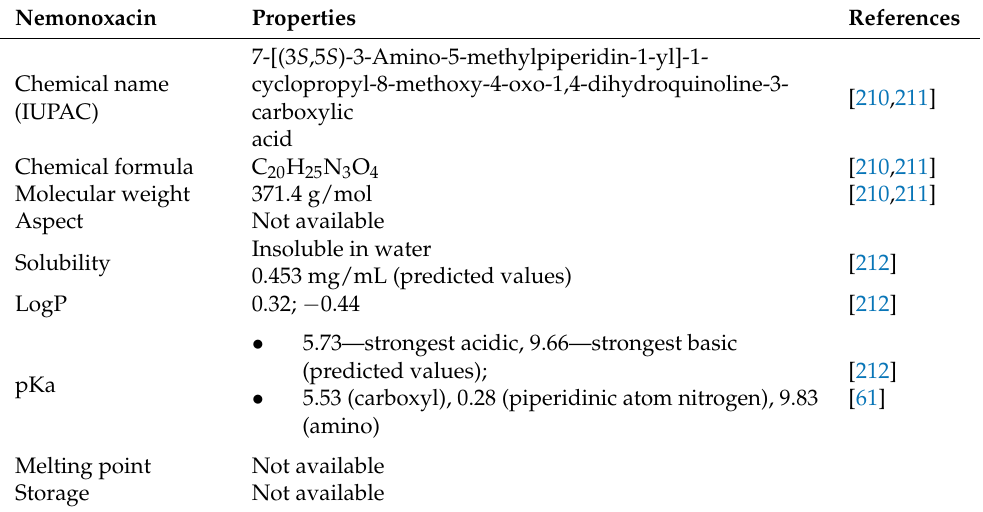
Table 8. Physico-chemical properties of